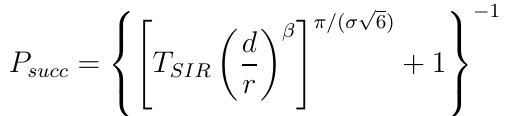
Figure 2. The impact of channel parameters on the success probability P and β = 4 . (a) P